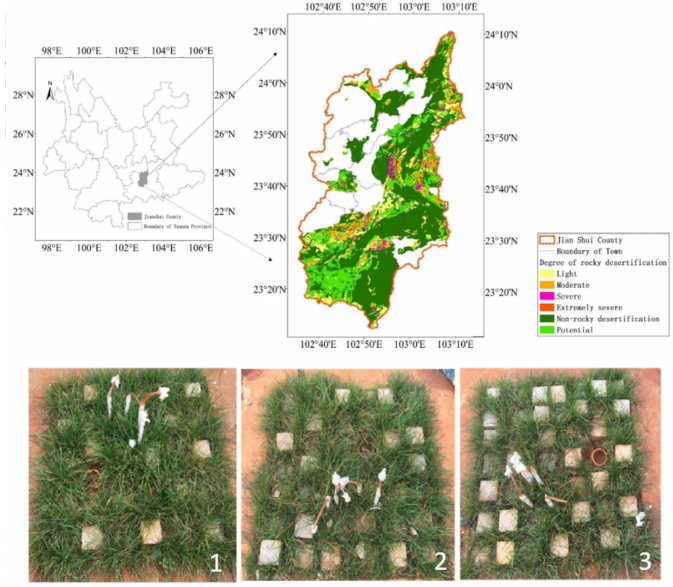
Figure 1. Geographical location of the study site and bed rock configurations tested (1, 2 and 3), whose characteristics are displayed in Table